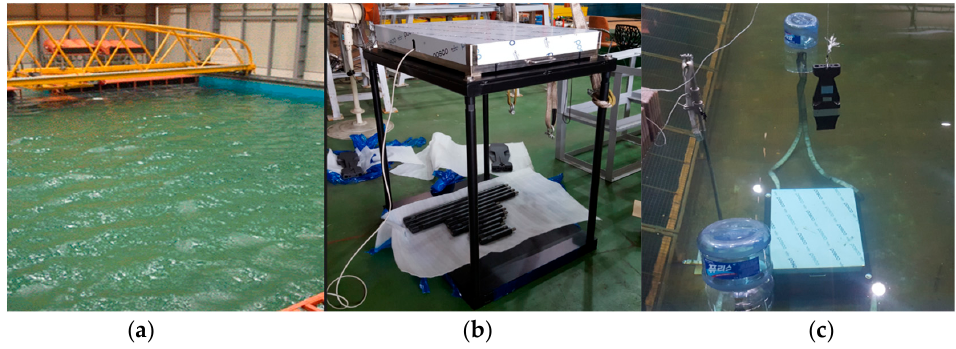
Figure 7. Experimental environment: ( a ) Water basin; ( b ) load cell with sensor plate; ( c ) crusher.